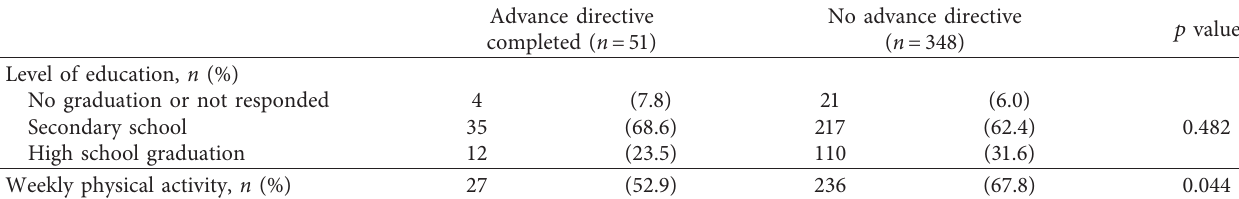
Table 2: Level of education and weekly physical activity. Advance